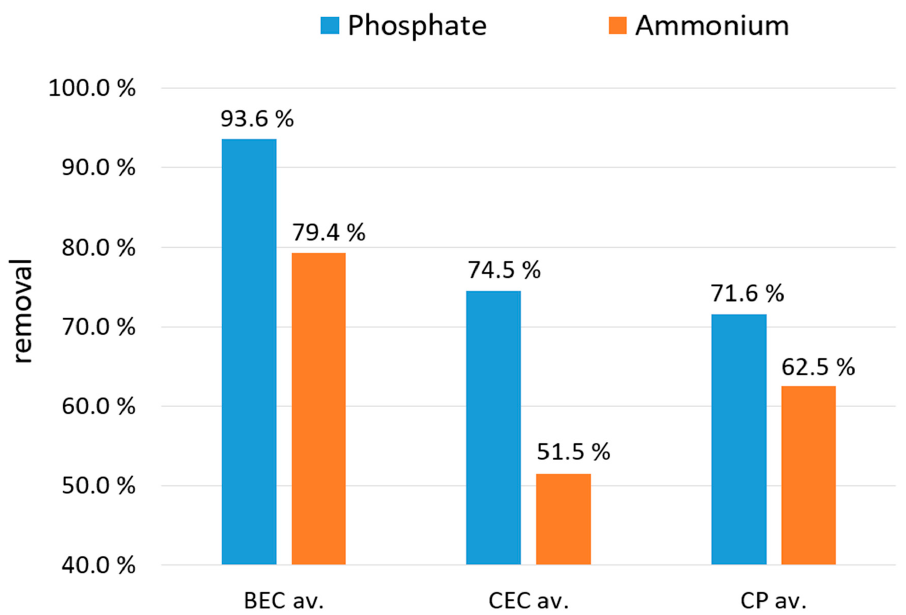
Figure 5. Average phosphate and ammonium removal (%) by BEC, CEC, and CP in synthetic water treatment. BEC av., Batch electrocoagulation average value; CEC av., continuous electrocoagulation average value; CP av., chemical precipitation average value.